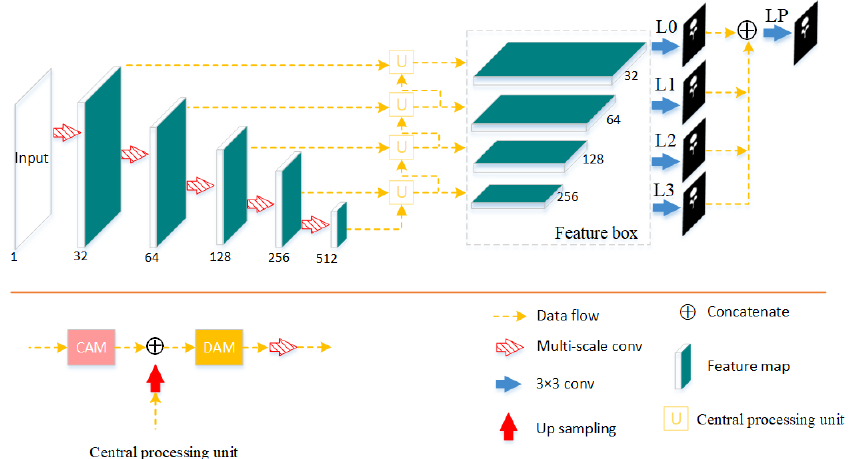
Figure 2. The top is a schematic drawing of our Verte-Box architecture. The bottom left is the central processing unit which a contains channel attention module (CAM) and dual attention module (DAM). L0–L3 are auxiliary segmentation loss terms, and Lp is a main loss. ‘Verte’ denotes vertebrae, and ‘box’ denotes feature